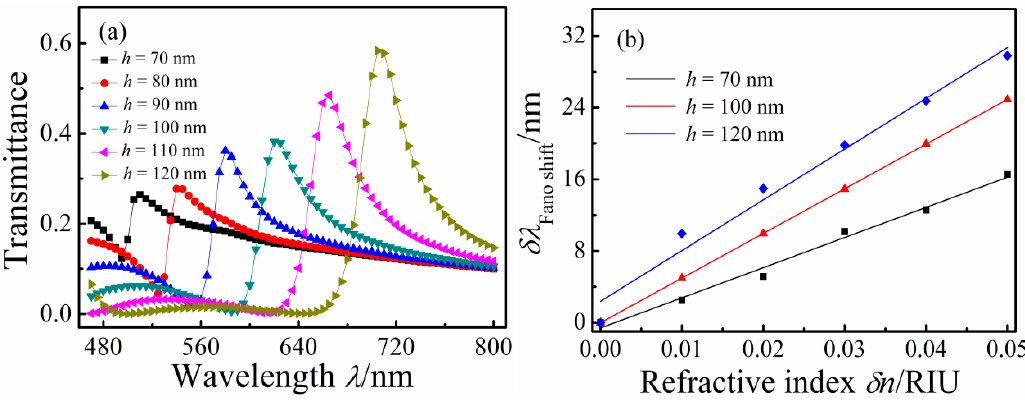
Figure 7. ( a ) Transmission spectra; and ( b ) Fano resonance wavelengths of MIM waveguides-coupled double rectangular cavities with different double rectangular cavities heights h .